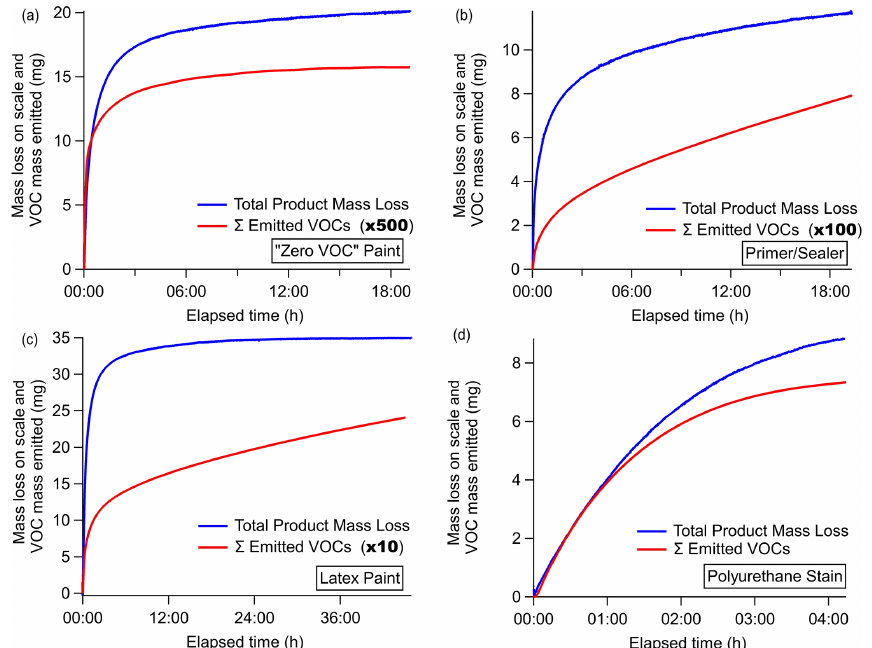
Figure 6. Total product mass loss measured on the scale (blue) overlaid with the total mass emitted as VOCs (red) measured by the PTR- ToF-MS as a function of elapsed time. The emitted VOC scalar is indicated in the legend of each